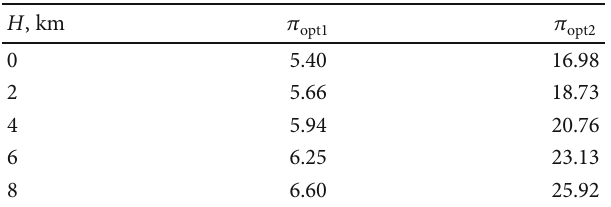
Table 7: Variations in optimum compressor pressure ratios π and π opt2 with H